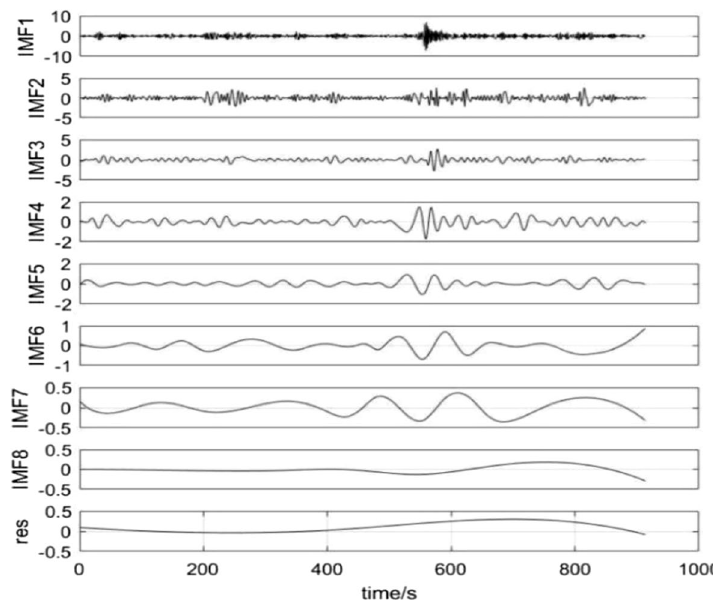
Fig. 2 EEMD decomposition of log‑returns for the AIRO index